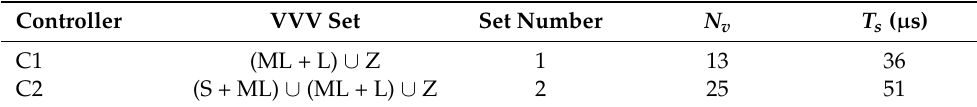
Table 1. VVV constellations.